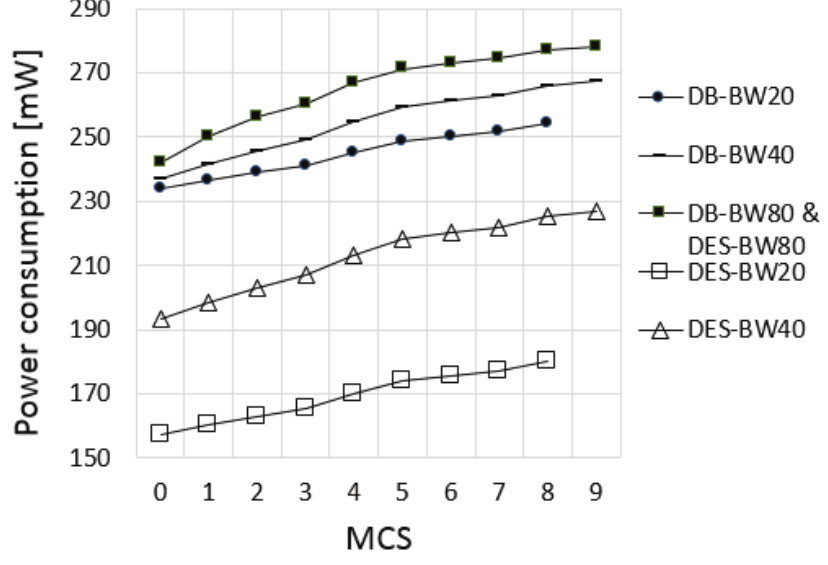
(cid:3) Figure 6. Energy consumption over various parameters: MCS, bandwidth, and operating scheme in the active mode.